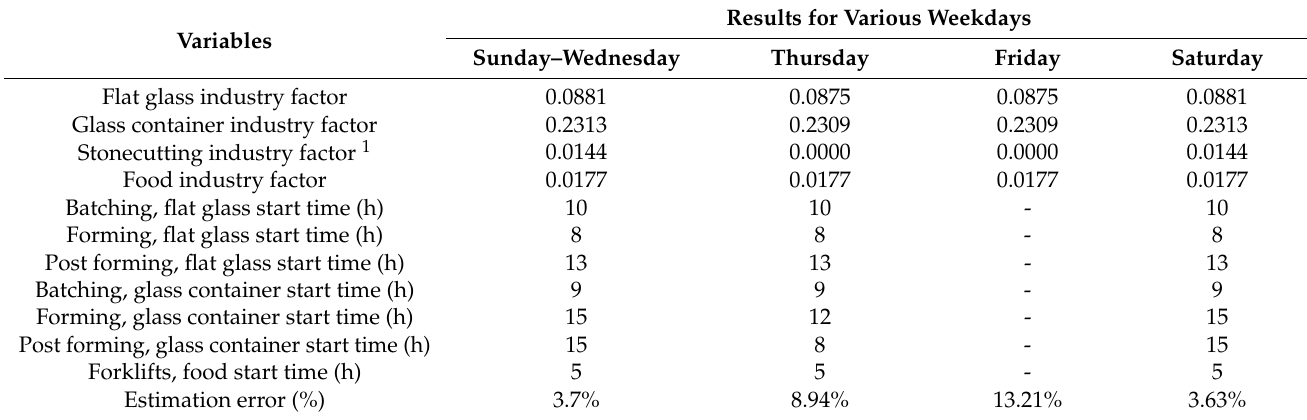
Table 17. The optimum value of the variables for various weekdays in a winter